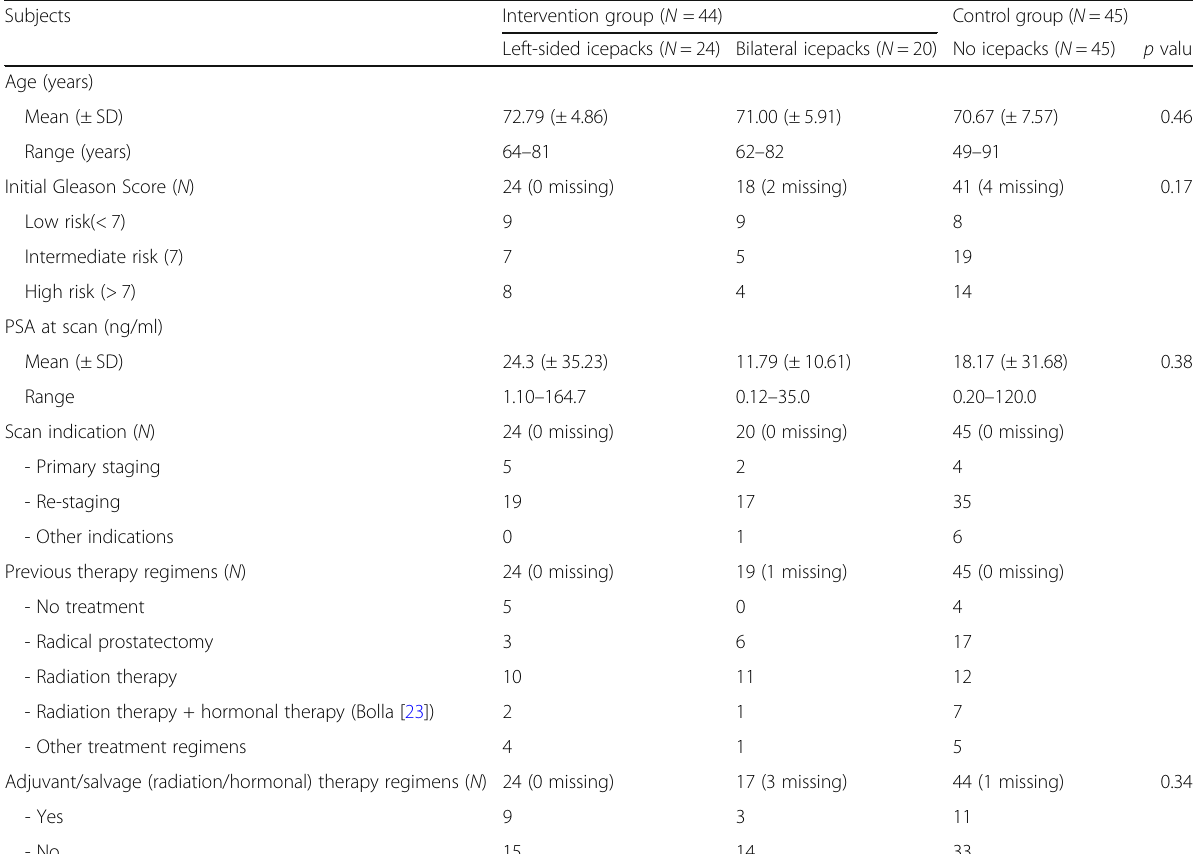
Table 1 Baseline characteristics